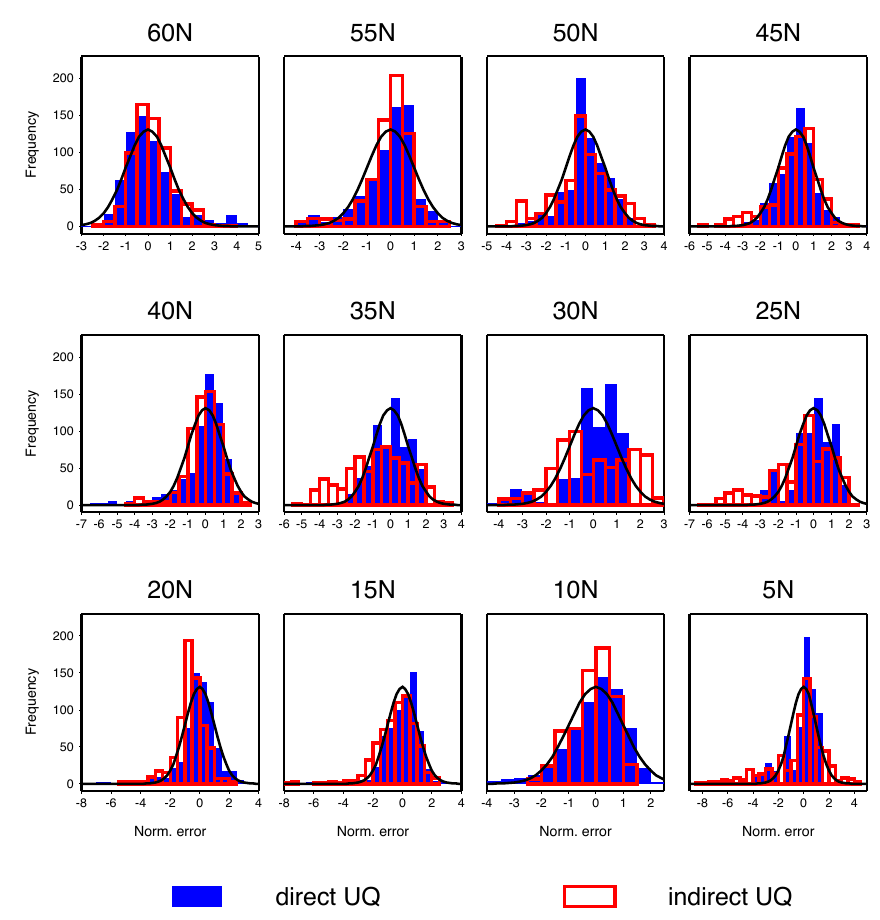
Figure 7. 1998 distributions of the normalized error for the uninformed emulator constructed using the direct and indirect uncertainty quantification methods: D Ud and D Ui . Results for 9 of the 10 parameter vector experiments are combined. Experiment 6, for which large extremes occur, is excluded. The predicted normalized error distribution, over-plotted for reference, is Gaussian with zero mean and unit standard deviation at all times and